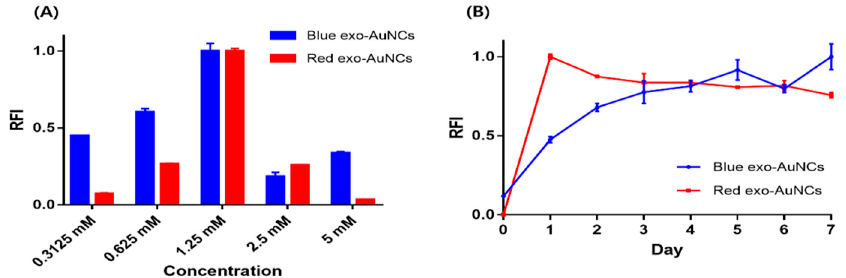
Figure 2. Optimization of conditions for synthesis of exo-AuNCs. ( A ) The effect of Au ion concentration on the formation of blue- and red-emitting exo-AuNCs. The exosome concentration was fixed at 6.25 mg/mL. The relative fluorescence intensity (RFI) was calculated by dividing the fluorescence intensity at different Au ion concentrations (0.3125, 0.625, 1.25, 2.5, and 5 mM) by the maximum fluorescence intensity at emission wavelengths of 460 nm (blue) and 670 nm (red); both blue- and red-emitting exo-AuNCs were excited at 360 nm. ( B ) The effect of reaction time on the formation of blue- and red-emitting exo-AuNCs. The RFI was calculated by dividing the fluorescence intensity at different reaction times (0 to 7 days) by the maximum fluorescence intensity at emission wavelengths of 460 nm (blue) and 670 nm (red); the red dot represents the RFI at 670 nm; both blue- and red-emitting exo-AuNCs were excited at 360 nm.